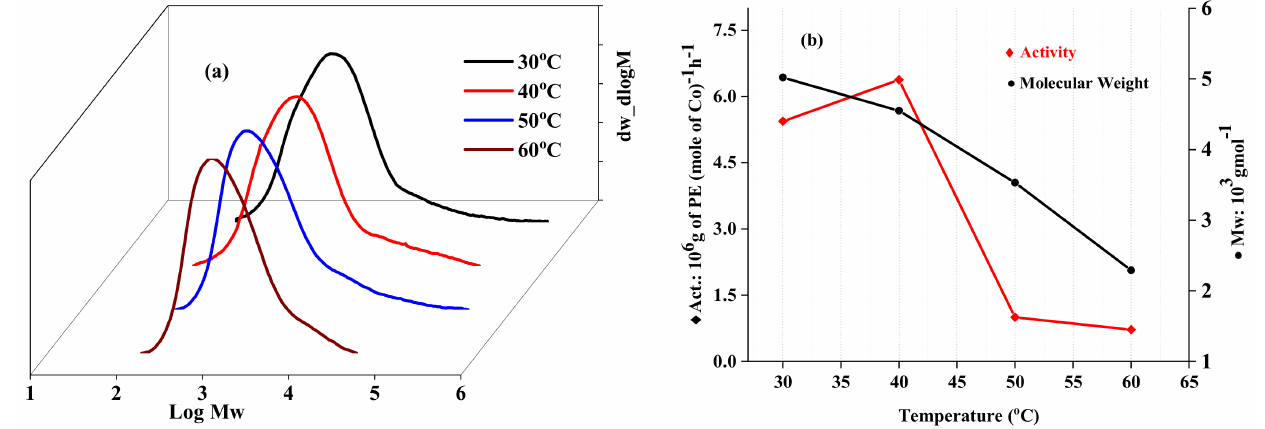
Figure 3. GPC curves of the obtained polyethylene ( a ); activity and M w as a function of reaction temperature ( b ) for the Co1 /MAO system (Table 2, entries